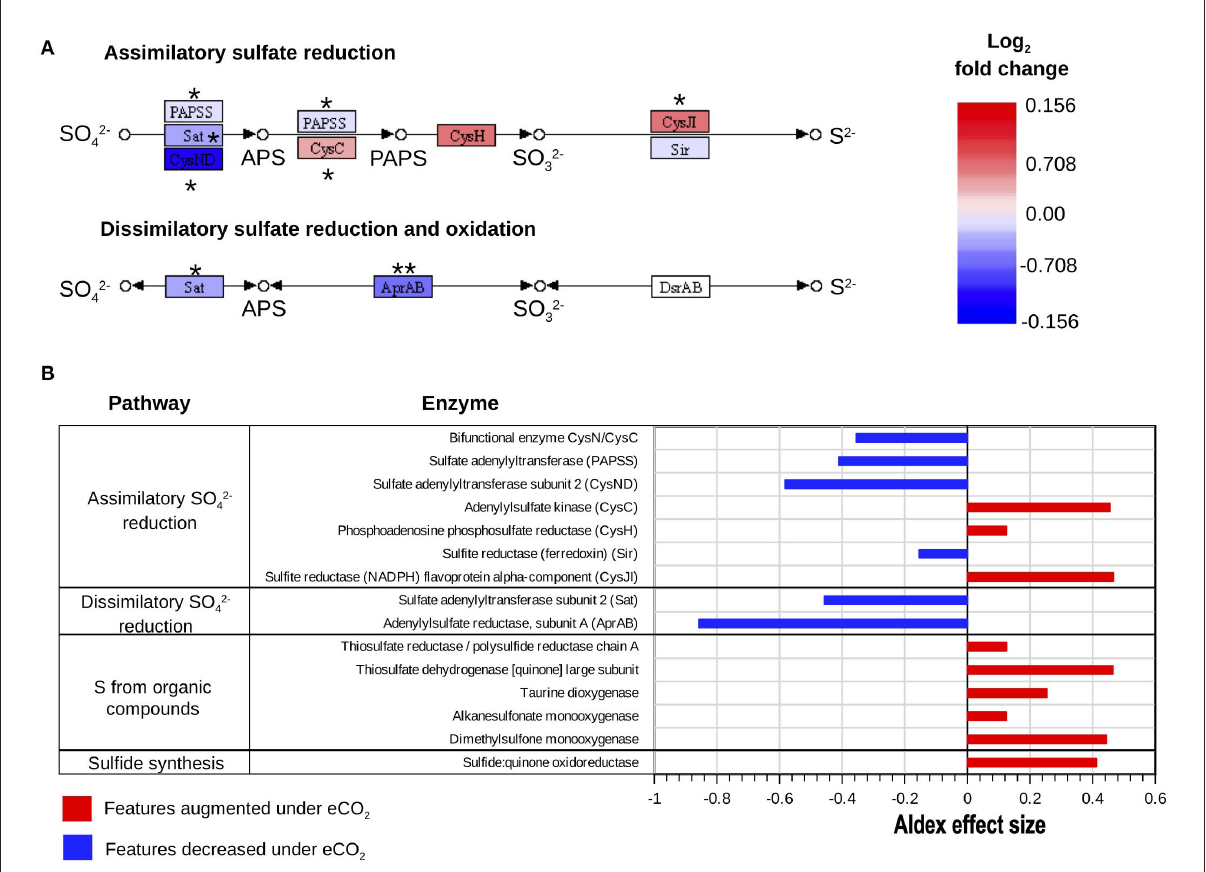
FIGURE5 Reconstructed KEGG (Kanehisa and Goto, 2000) pathways of S metabolism. (A) Assimilatory SO 2 − 4 reduction and dissimilatory SO 2 − 4 reduction and oxidation processes expressed as log 2 fold change of transcripts as relative abundance. ALDEx2 effect size: (***) > 0.8, (**) > 0.5, (*) > 0.2. (B) Differential abundance of S cycle transcripts with absolute ALDEx2 effect sizes > 0.1 involved in assimilatory SO 2 − 4 reduction, dissimilatory SO 2 − 4 reduction, and oxidation, and uptake of S from organic compounds and sulfide